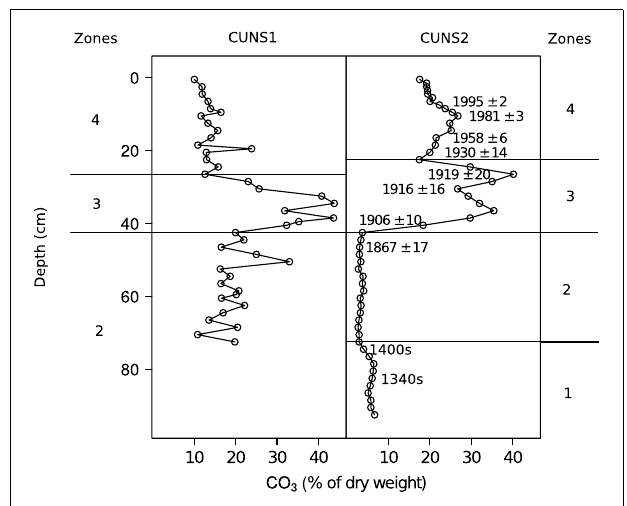
FIGURE 3 | Carbonate concentrations in cores CUNS1 and CUNS2, shown with calendar years obtained by 210 Pb-dating of CUNS2 with errors ( ± ), and approximate calendar years based on radiocarbon dates (see Table 1 for details).